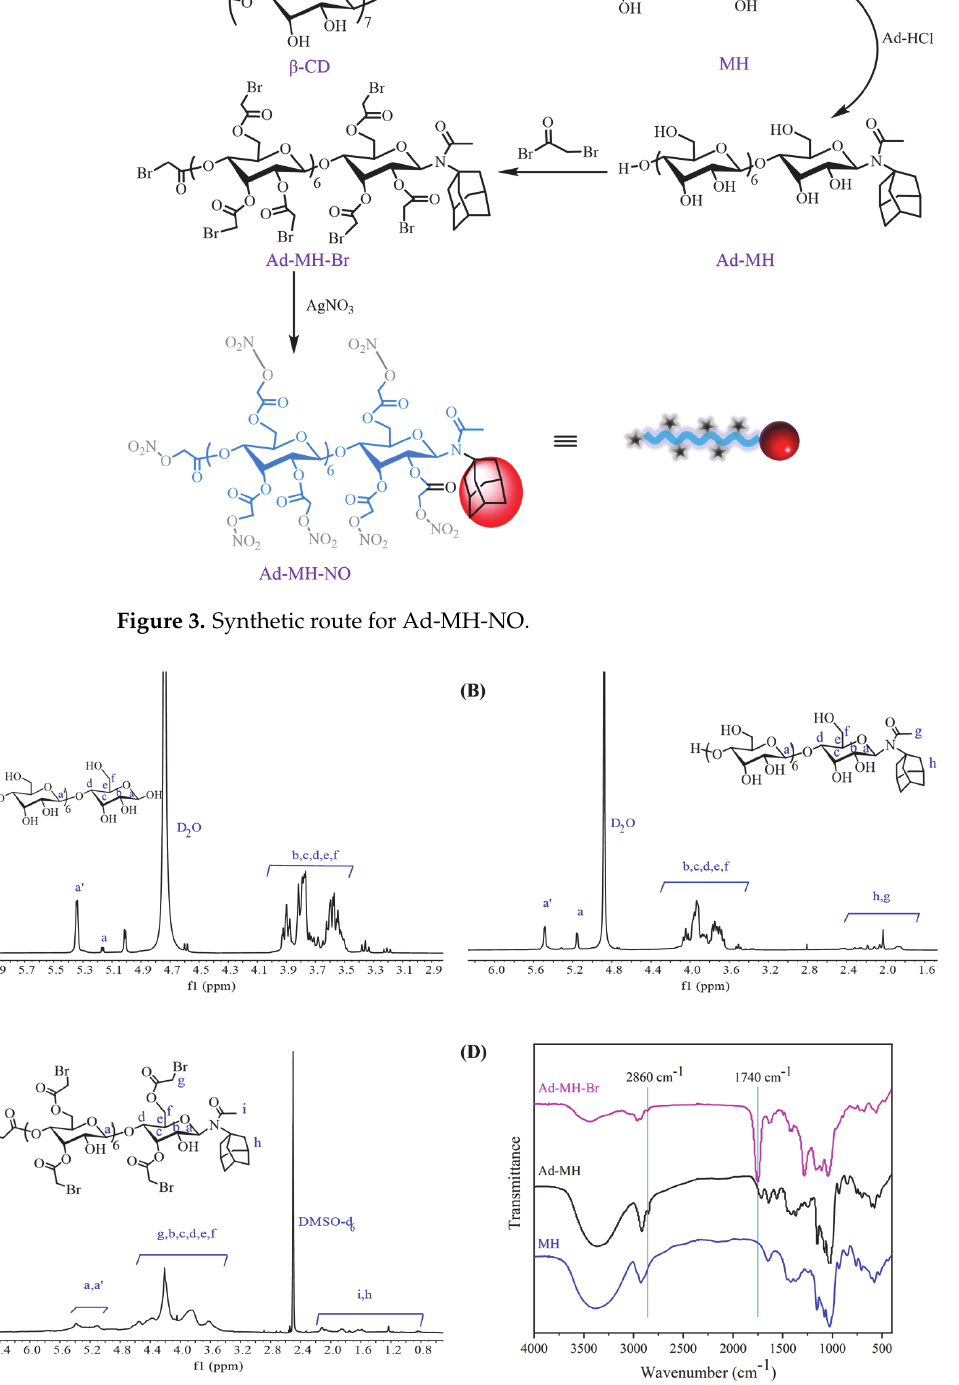
Figure 4. 1 H NMR spectra for ( A ) MH, ( B ) Ad − MH, ( C ) Ad − MH − Br, ( D ) IR spectra for Ad − MH/Ad − MH − Br/Ad − MH − NO.